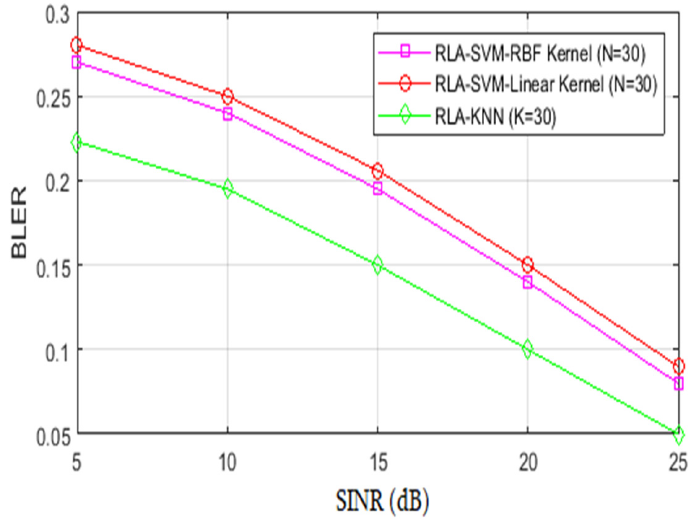
Figure 6. BLER versus SINR for RLA–SVM–RBF, RLA–SVM–linear, and RLA–KNN.